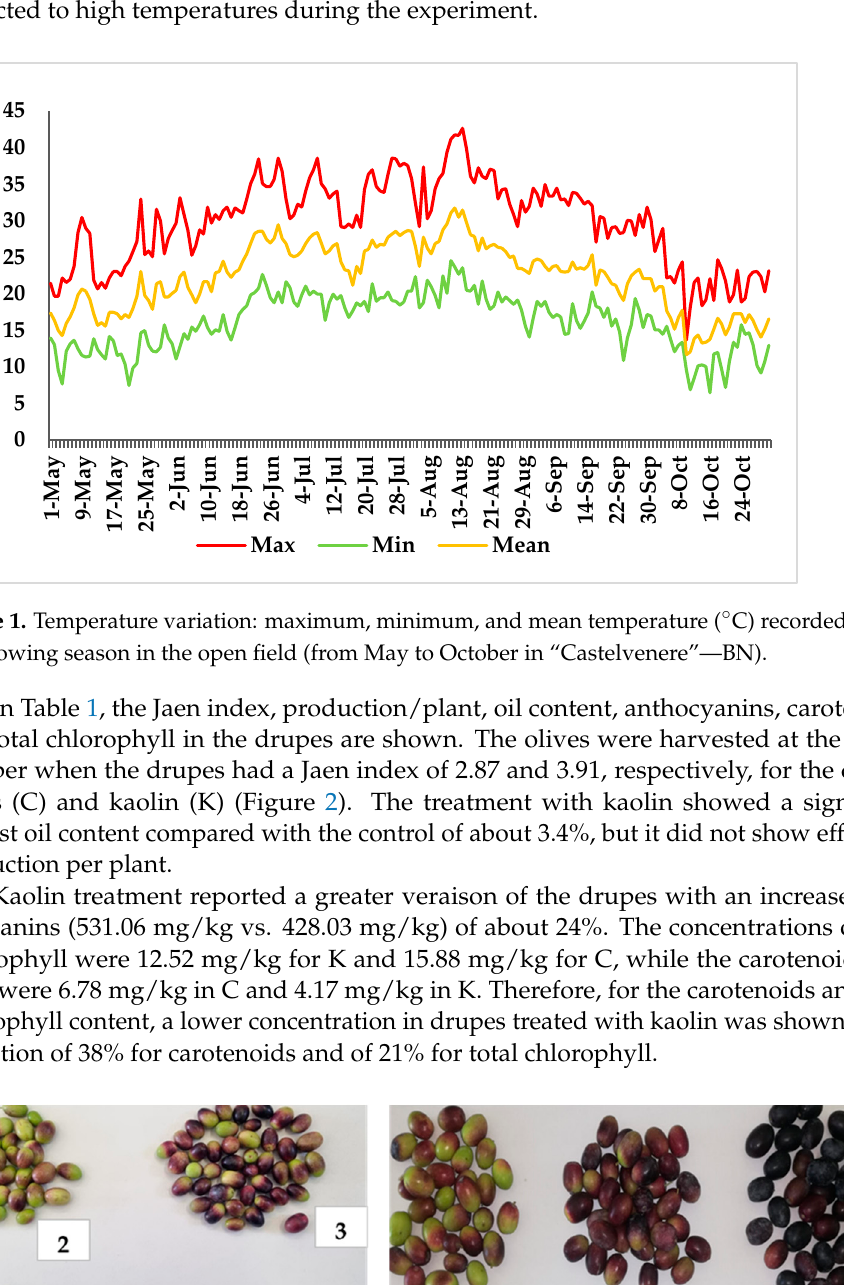
Values are mean ± standard error. Different letters indicate significant differences according to Stu- dent’s t -test ( p = 0.05). Asterisks indicate significant effect of kaolin treatment according to ANOVA (ns = not significant; * = p < 0.05; ** = p < 0.01; *** = p < 0.001).